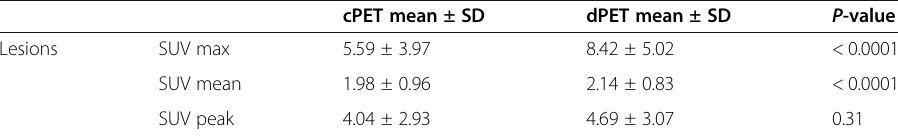
Table 4 SUVs in tumor lesions ( n =